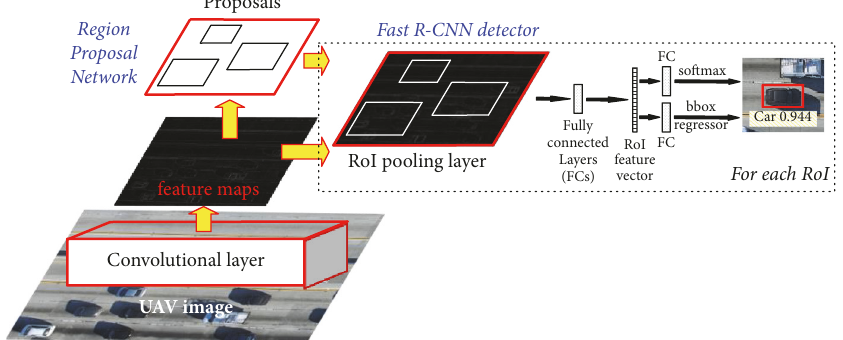
Figure 2: The architecture of Faster R-CNN, from [20, 21].